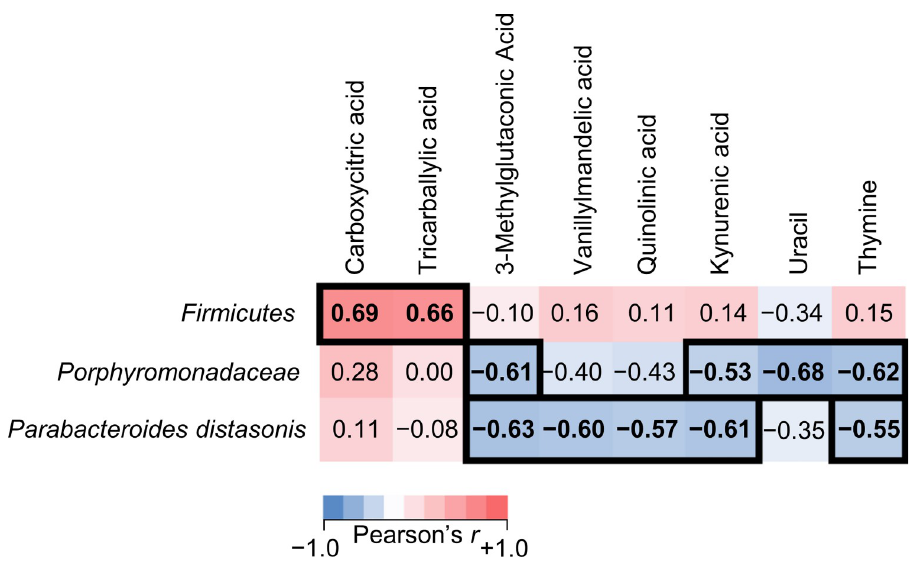
Fig 4. Pearson’s correlation heat map correlations between fecal microbiota and urinary metabolites. The color strip (down legend) represents the correlation between each item. The darker color indicates that the correlation coefficient increases gradually. For example, red shows a positive correlation, while blue shows a negative correlation. The values indicate Pearson’s correlation coefficients ( r ), and bold letters indicate p < 0.05.